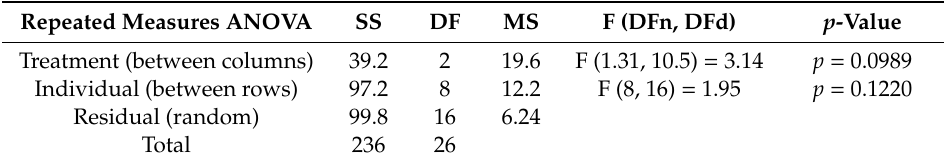
Table 2. ANOVA statistics of RA mean root mean square (mRMS) values at the beginning of the session (day 1, week 6 and week